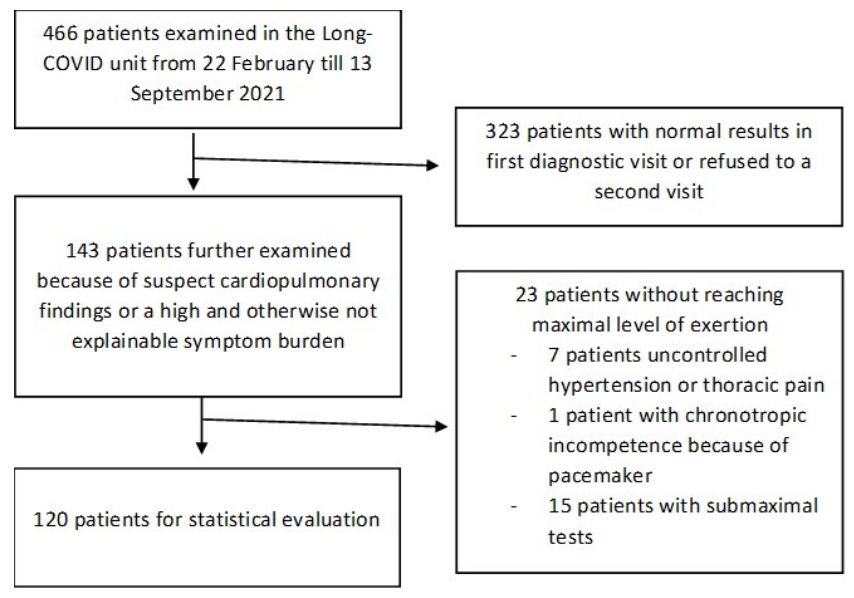
Figure 1. Flowchart of patient enrollment.